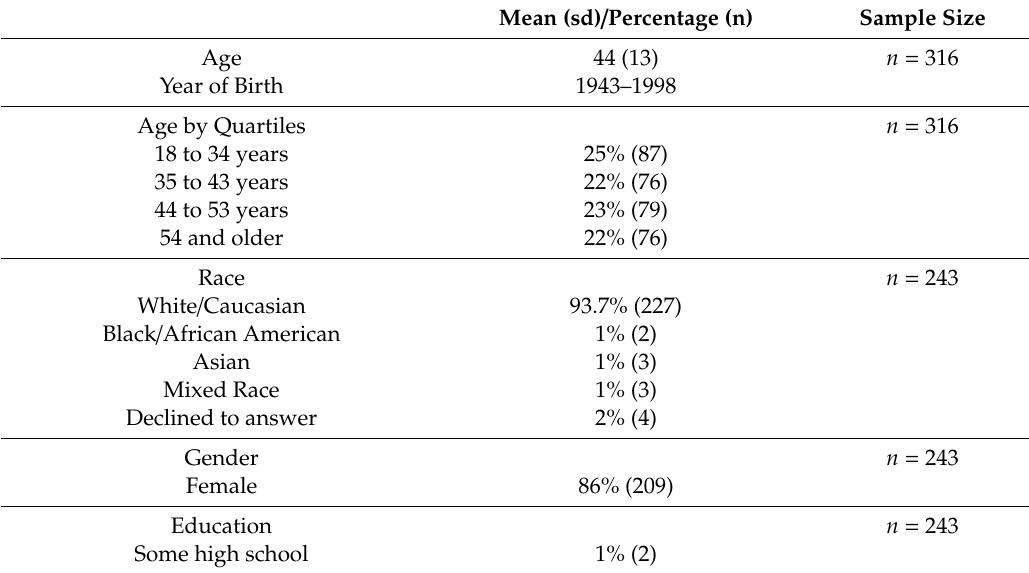
Table 1. Demographic characteristics and religious practices of the